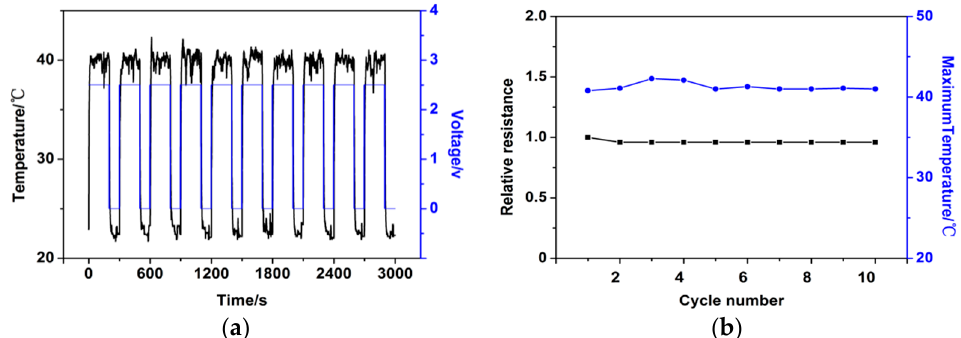
Figure 7. The images of ( a ) time-dependent temperature curve under a cyclical voltage of 2.5 V. ( b ) relative resistance and maximum temperature of heating system for 10